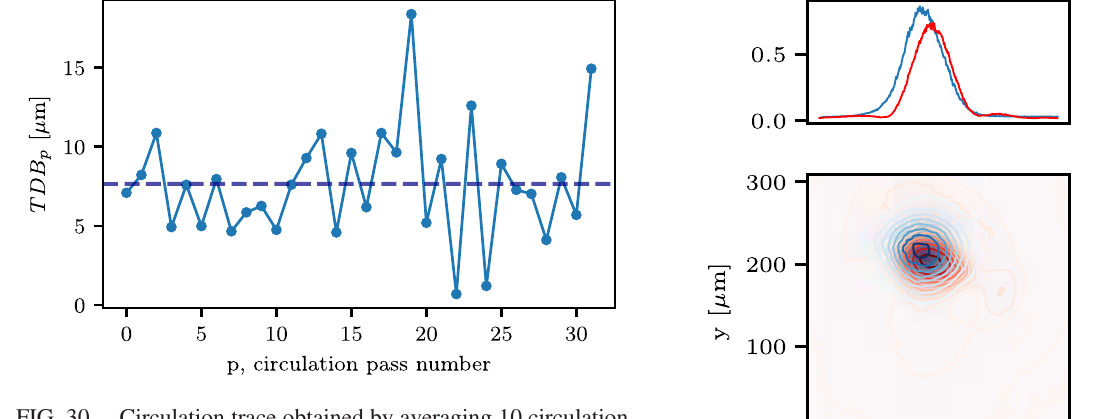
FIG. 30. Circulation trace obtained by averaging 10 circulation traces after fast scan optimization on M2.TZ, and laser beam injection. The error in position for each point is (cid:2) 4 μ m.